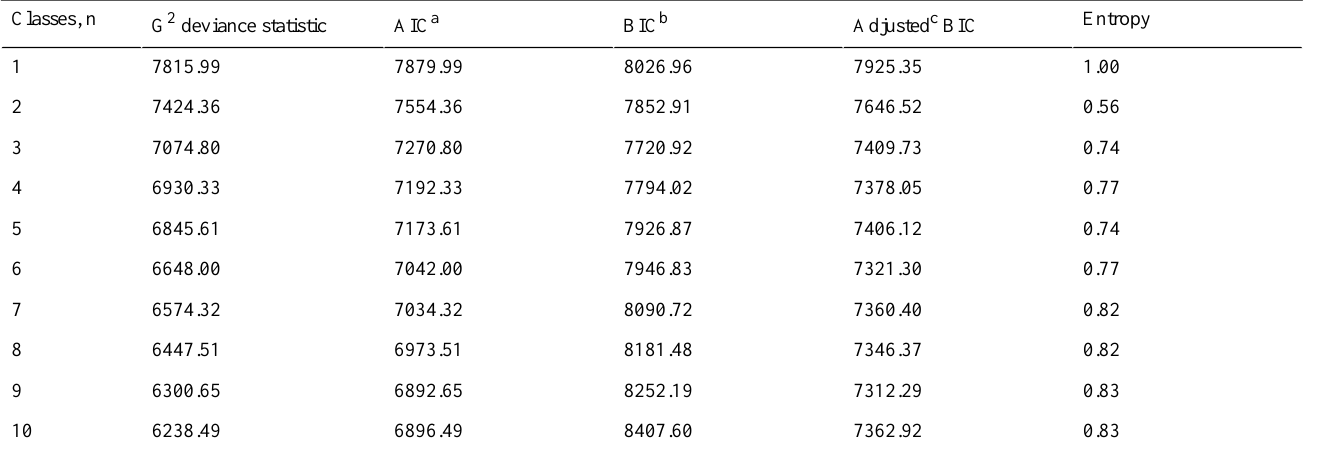
Table 1. Latent class model selection